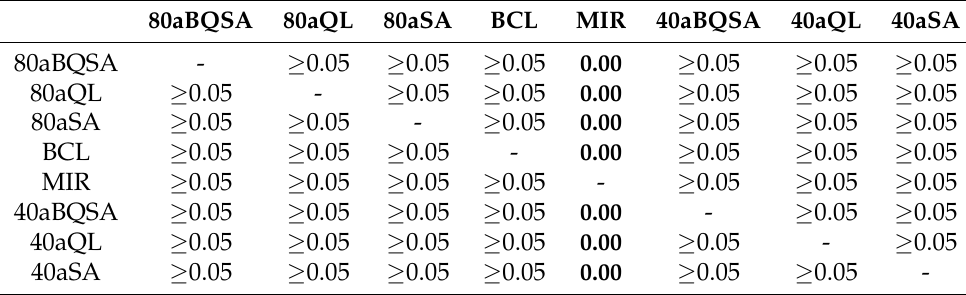
Table 7. Average p -value of SCA compared to others algorithm.